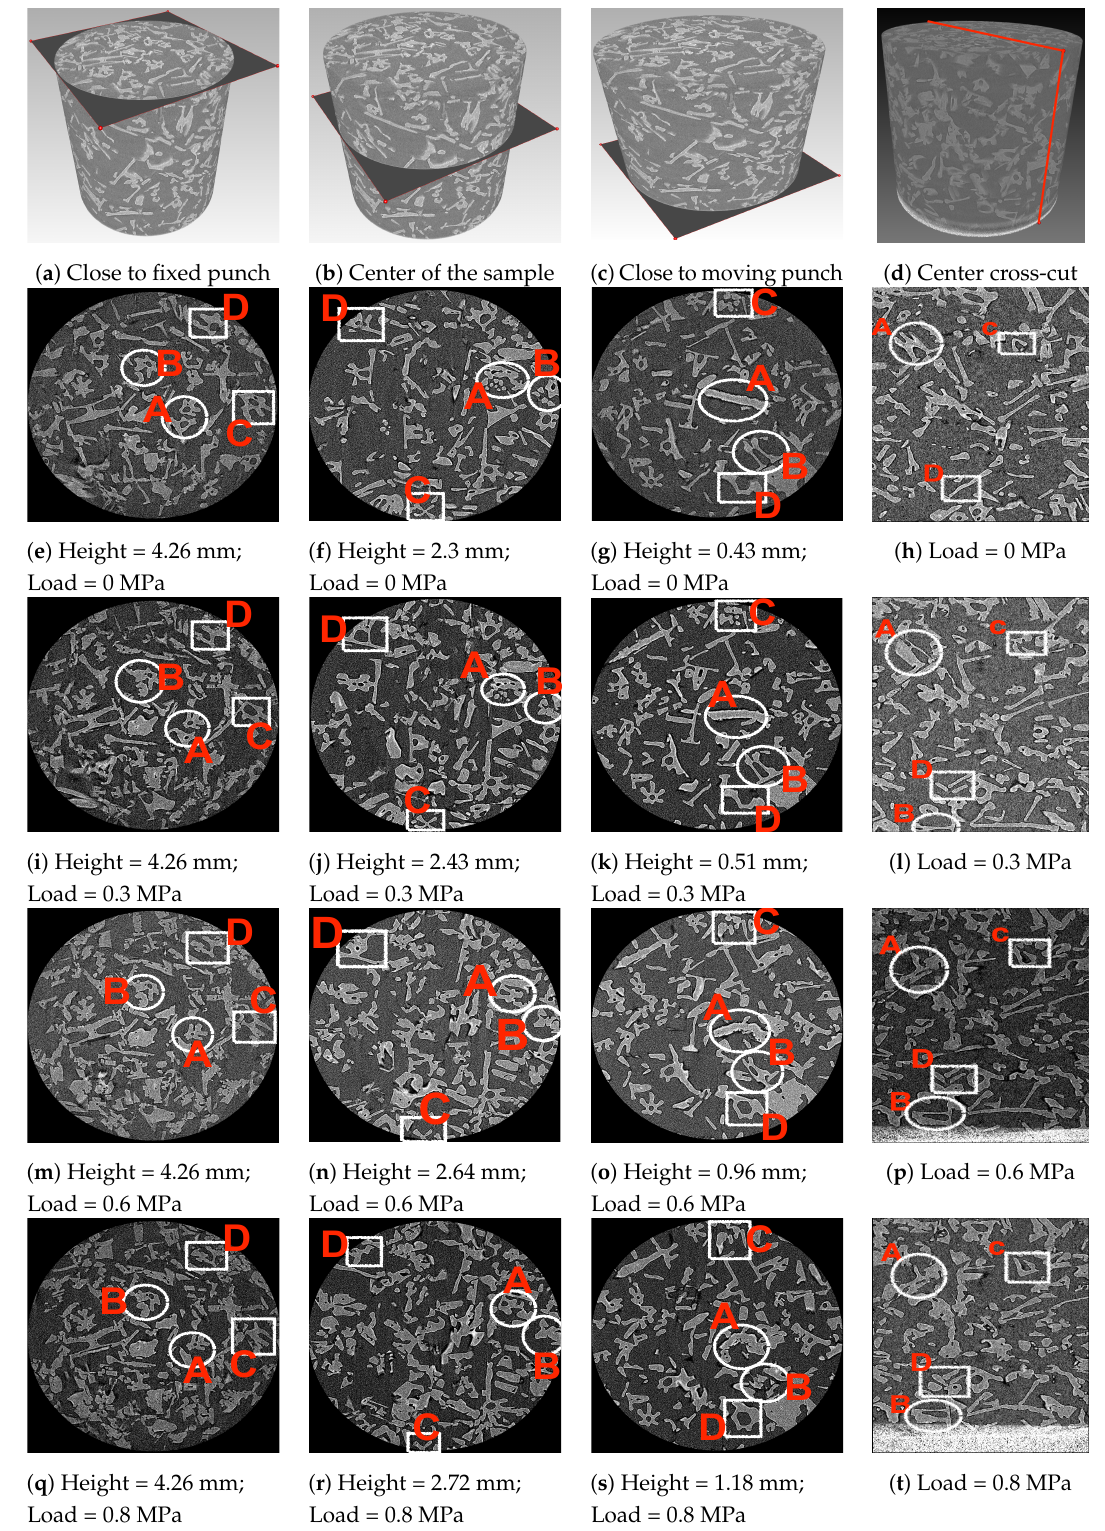
Figure 7. Distribution of ice crystals at four slices of the investigated snow volume at a given load. Note that the compaction is applied from the bottom of the snow volume via moving punch and it is visible in Figure